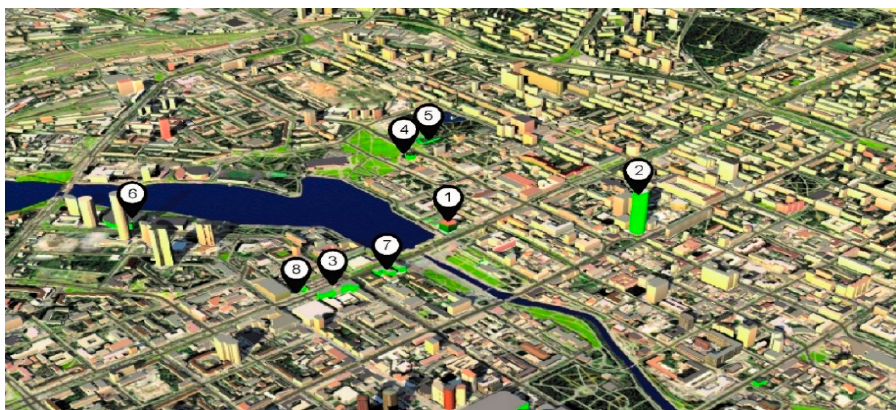
Figure 1. Visual model of Yekaterinburg with an indication of buildings that young people find attractive and interesting.